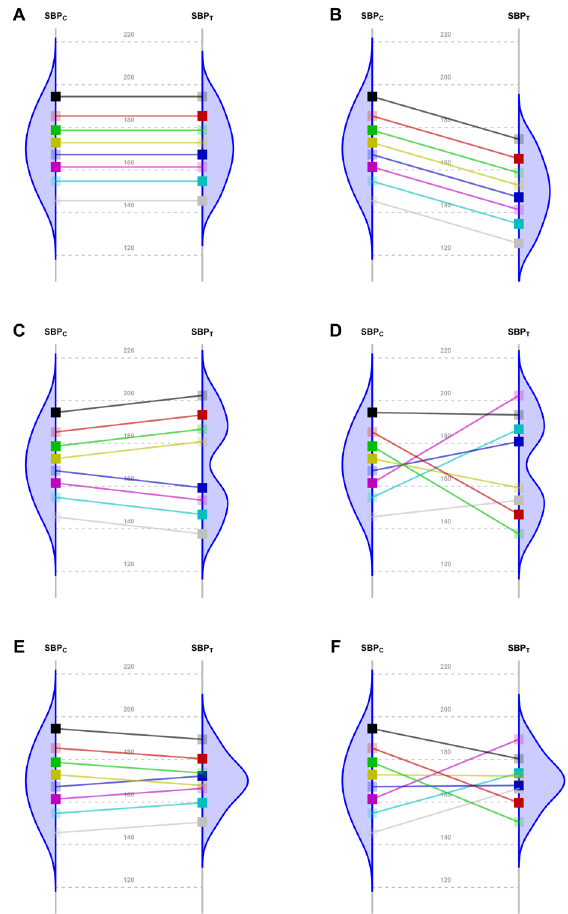
Figure 1. Scenarios representing fictional trials using 8 participants with systolic blood pressure as the primary endpoint. Because of the random allocation to one of two treatment arms, we will observe only one of the two potential outcomes for each patient: either under T or under C. Fully saturated colors represent observed systolic blood pressure (SBP) values, and transparent squares represent missing potential SBP values. The line slope indicates the individual non-observable effect for each patient. Densities are the potential distributions